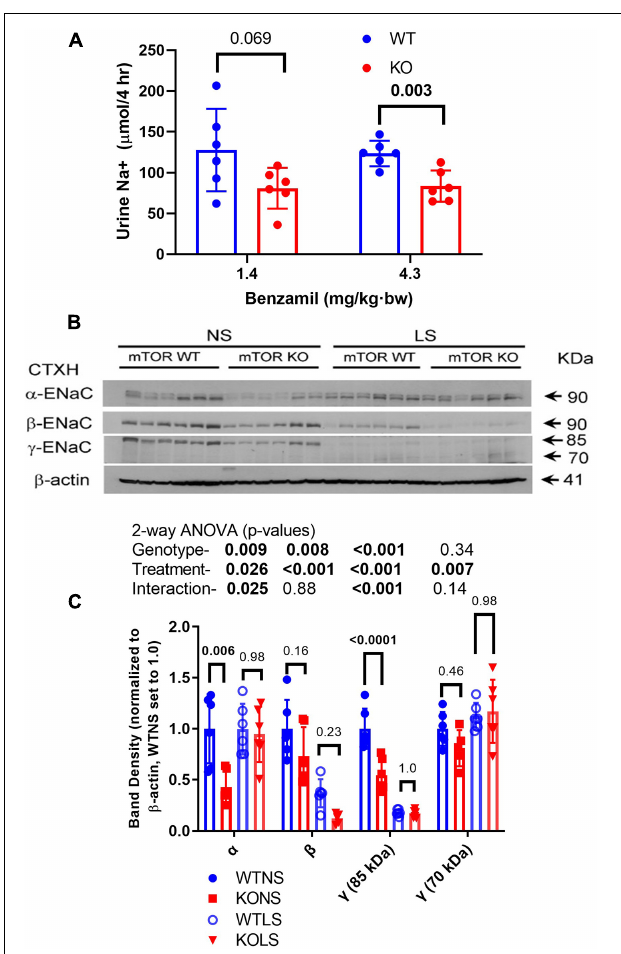
FIGURE 4 | Epithelial sodium channel (ENaC) activity and expression in kidney is reduced in KO mice. (A) Natriuretic sensitivity to the ENaC-select antagonist, benzamil was used as a surrogate for in vivo ENaC activity. Male mice ( n = 6/genotype) were given a single intraperitoneal injection of benzamil @ 1.4 mg/kg · bw, urine collected in the subsequent 4-h period then measured for volume and Na+. The experiment was repeated the following week with 4.3 mg/kg · bw dose. (B) Male mice were fed NS or LS diet for 7-days ( n = 6/genotype/diet) then euthanized and kidneys harvested. (B) Western blots of kidney cortex homogenates loaded with 30 µ g/lane were probed with rabbit polyclonal antibodies against α -, β -, or γ -ENaC as indicated. A reprobe with β -actin (representative image) was used to normalize bands. (C) Band density summary (mean ± sem) and results of 2-way ANOVA (genotype × treatment). The major bands for all three subunits were significantly reduced ( p < 0.05) in the KO, relative to WT. The LS diet also significantly affected abundance of all bands